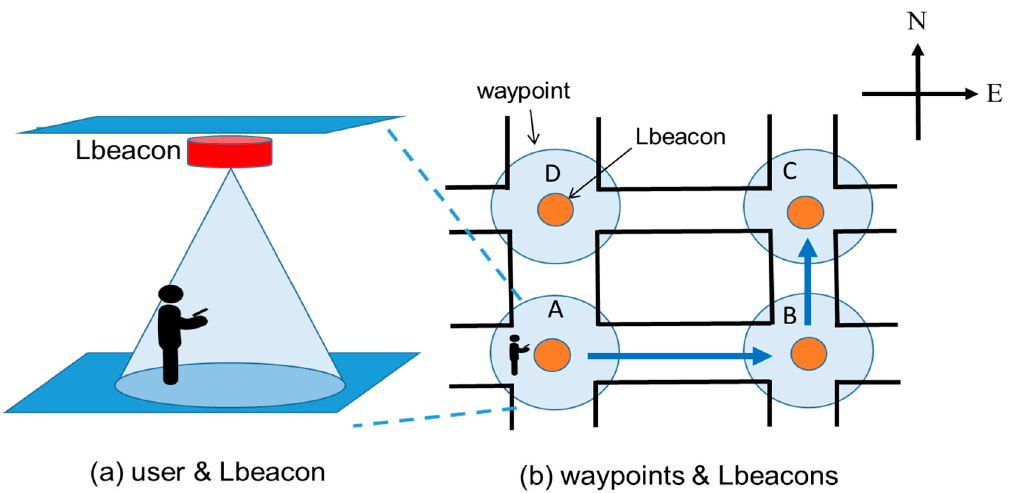
Figure 3. The positioning method of waypoint-based navigation [7]. ( a ) User and Lbeacon; ( b ) waypoint and Lbeacons.